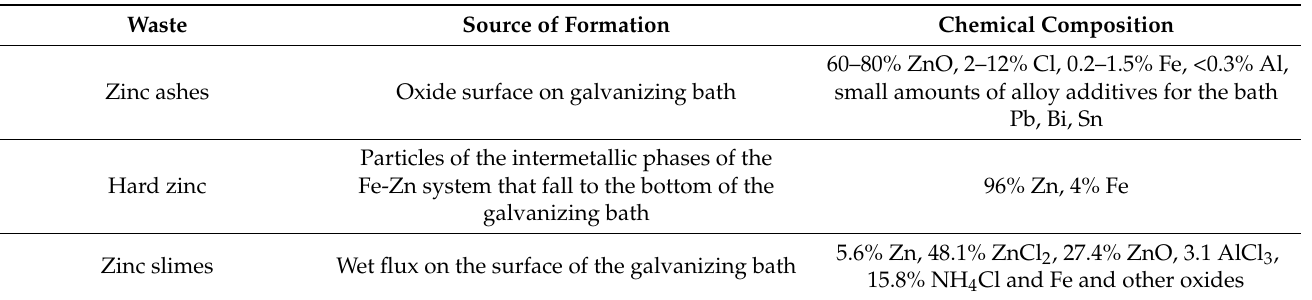
Table 7. Characteristics of various zinc wastes generated in the industry and during the production process, worked out based on